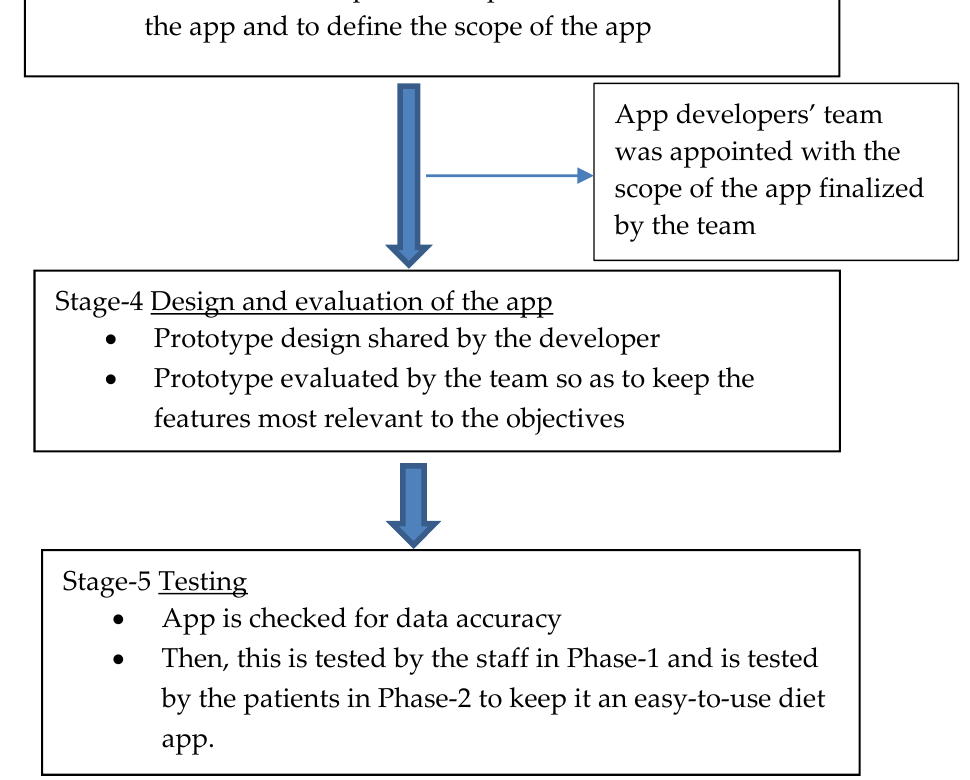
Figure 1. Flow chart of the IBD NutriCare App development.